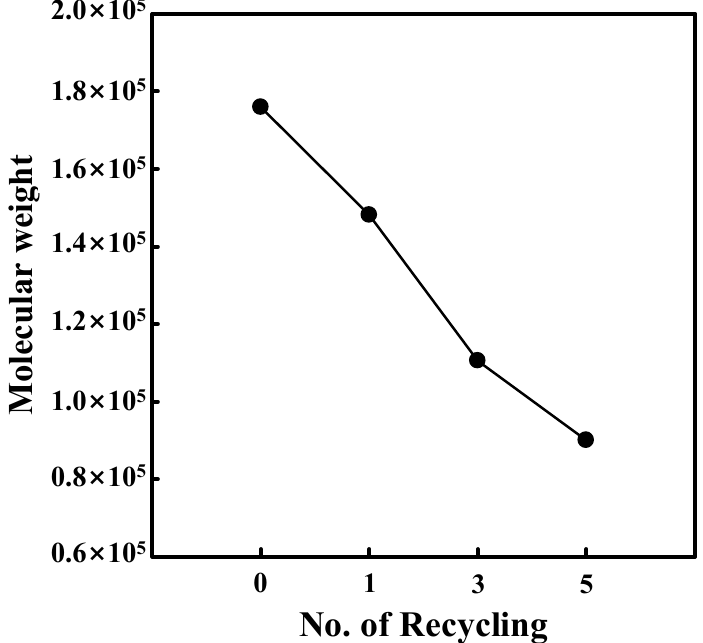
Figure 7. The molecular weight of PLA as a function of the number of recycling steps.